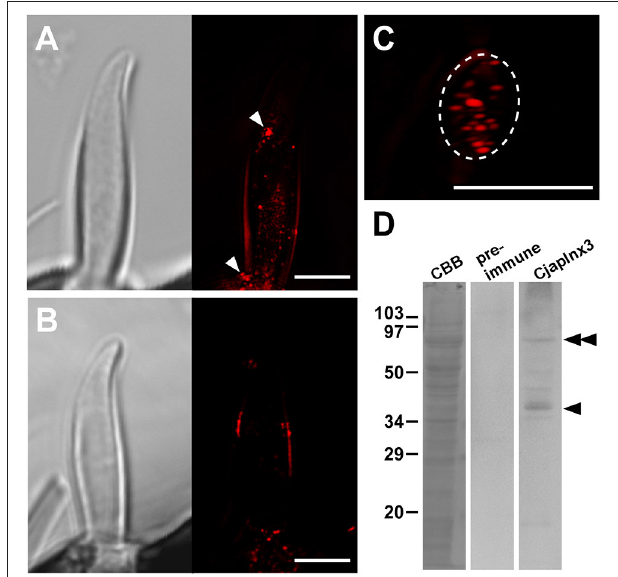
FIGURE 5 | Immunohistostaining for CjapInx3 in the Sensilla basiconica . (A) Differential interference image (Left) and fluorescence image of the longitudinal section of test sensillum treated with anti-CjapInx3 antiserum (Right). (C) A fluorescence image of the cross section of the test sensillum. Inner perimeter of the sensillar cuticle wall is traced with broken line. (B) Differential interference image (Left) and fluorescence image of the longitudinal section of control sensillum treated with pre-immune serum (Right). Bars indicate 5 µ m. (D) Western blot of the C. japonicus antennal proteins with anti-CjapInx3 antiserum used for the immunohistostaining. Arrowhead and double arrowhead indicate monomeric and dimeric CjapInx3.